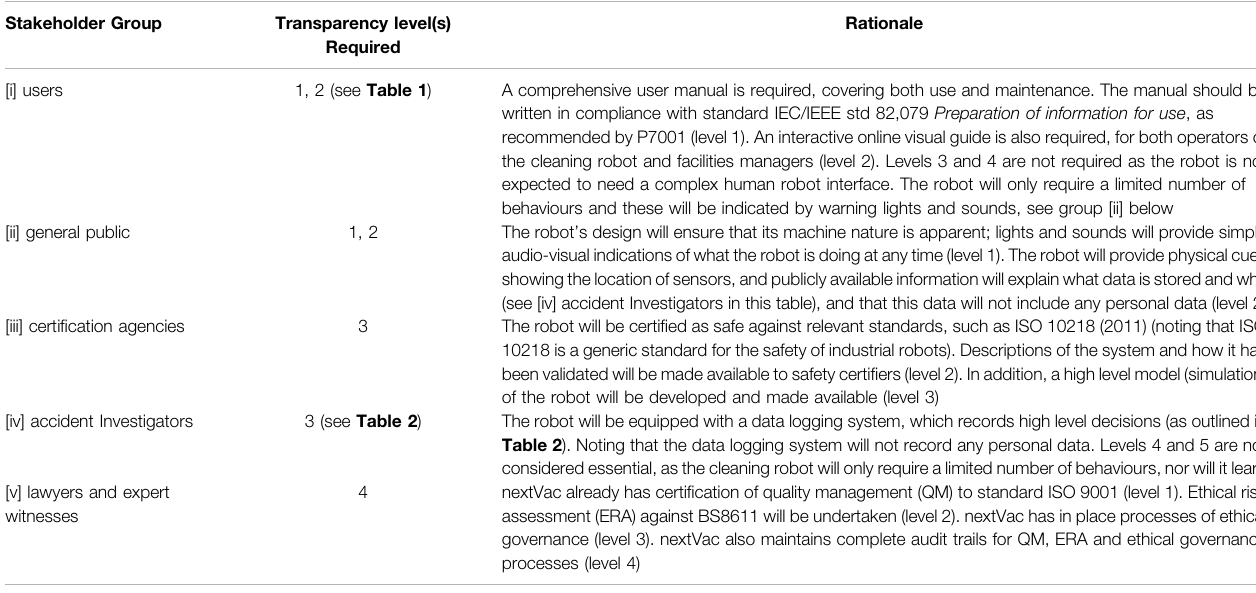
TABLE 4 | Outline system transparency speci fi cation (STS) for